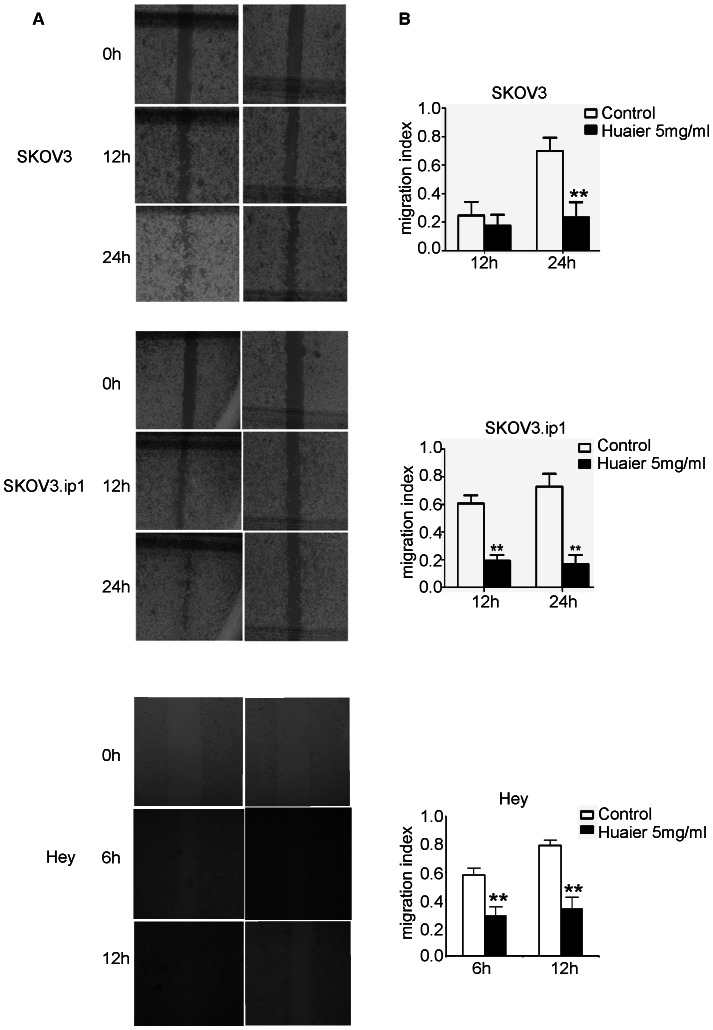
Huaier inhibited the migration of ovarian cancer cells in vitro, as measured in a scratch assay.(A) A straight wound area was generated in each culture well at the beginning, and administration of Huaier (5 mg/ml) showed a delayed process of wound closure compared with the untreated cells. Representative images of the control cells and 5 mg/mL Huaier-treated cells were acquired at 0, 12,24 h (SKOV3, SKOV3.ip1) or 0, 6, 12 h (Hey). (B) The migration indices were significantly inhibited by Huaier. The bars represent the migration index for each treatment, expressed as a value relative to the distance moved by the cell monolayer. The data are presented as means ± SD. The experiments were repeated at least three times. ** p<0.01 compared with the control.